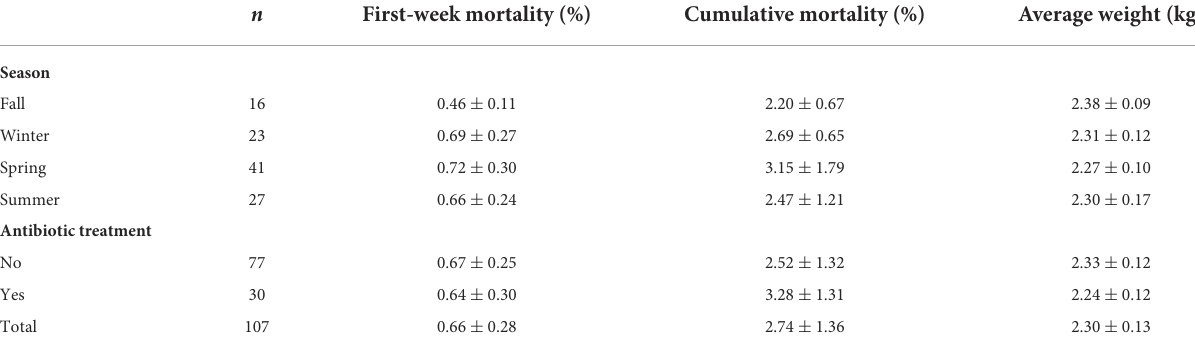
TABLE 1 Mean values and standard deviation of first-week mortality, cumulative mortality, and average weight, separately listed according to season and use of antibiotic treatment. n First-week mortality (%) Cumulative mortality (%) Average weight